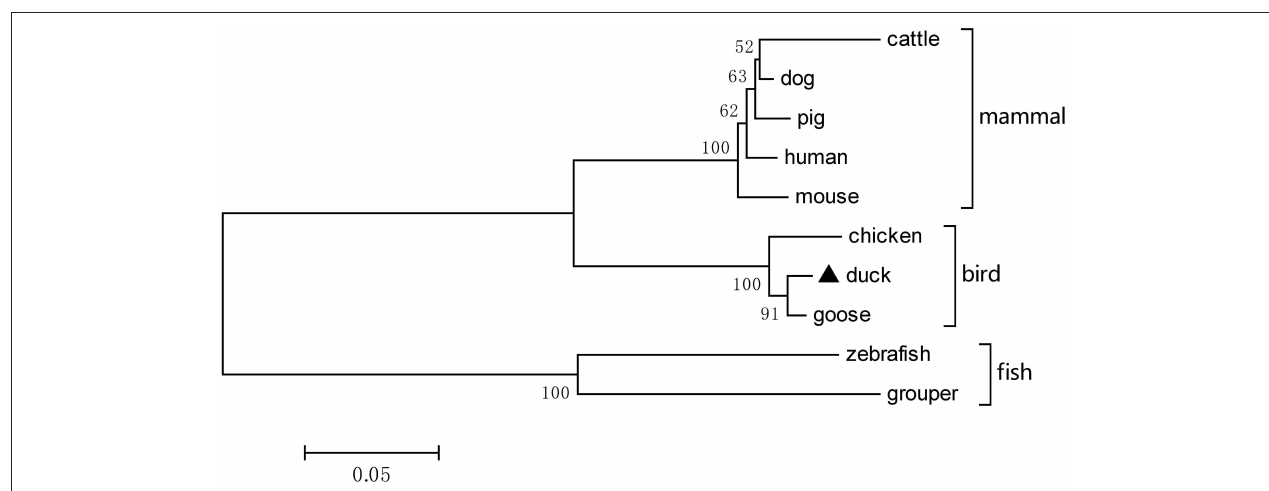
FIGURE 2 | A phylogenetic tree of duck TRIM32 and other animal TRIM32 were generated by MEGA 4.0 with the neighbor-joining method. The sequences are derived from GenBank. The accession numbers are goose (XP_013038246.1), chicken (XP_015135179.2), human (NP_036342.2), mouse (NP_444314.2), cattle (NP_001069292.1), dog (XP_005627017.1), pig (XP_005660438.1), zebrafish (NP_001107066.1), and grouper